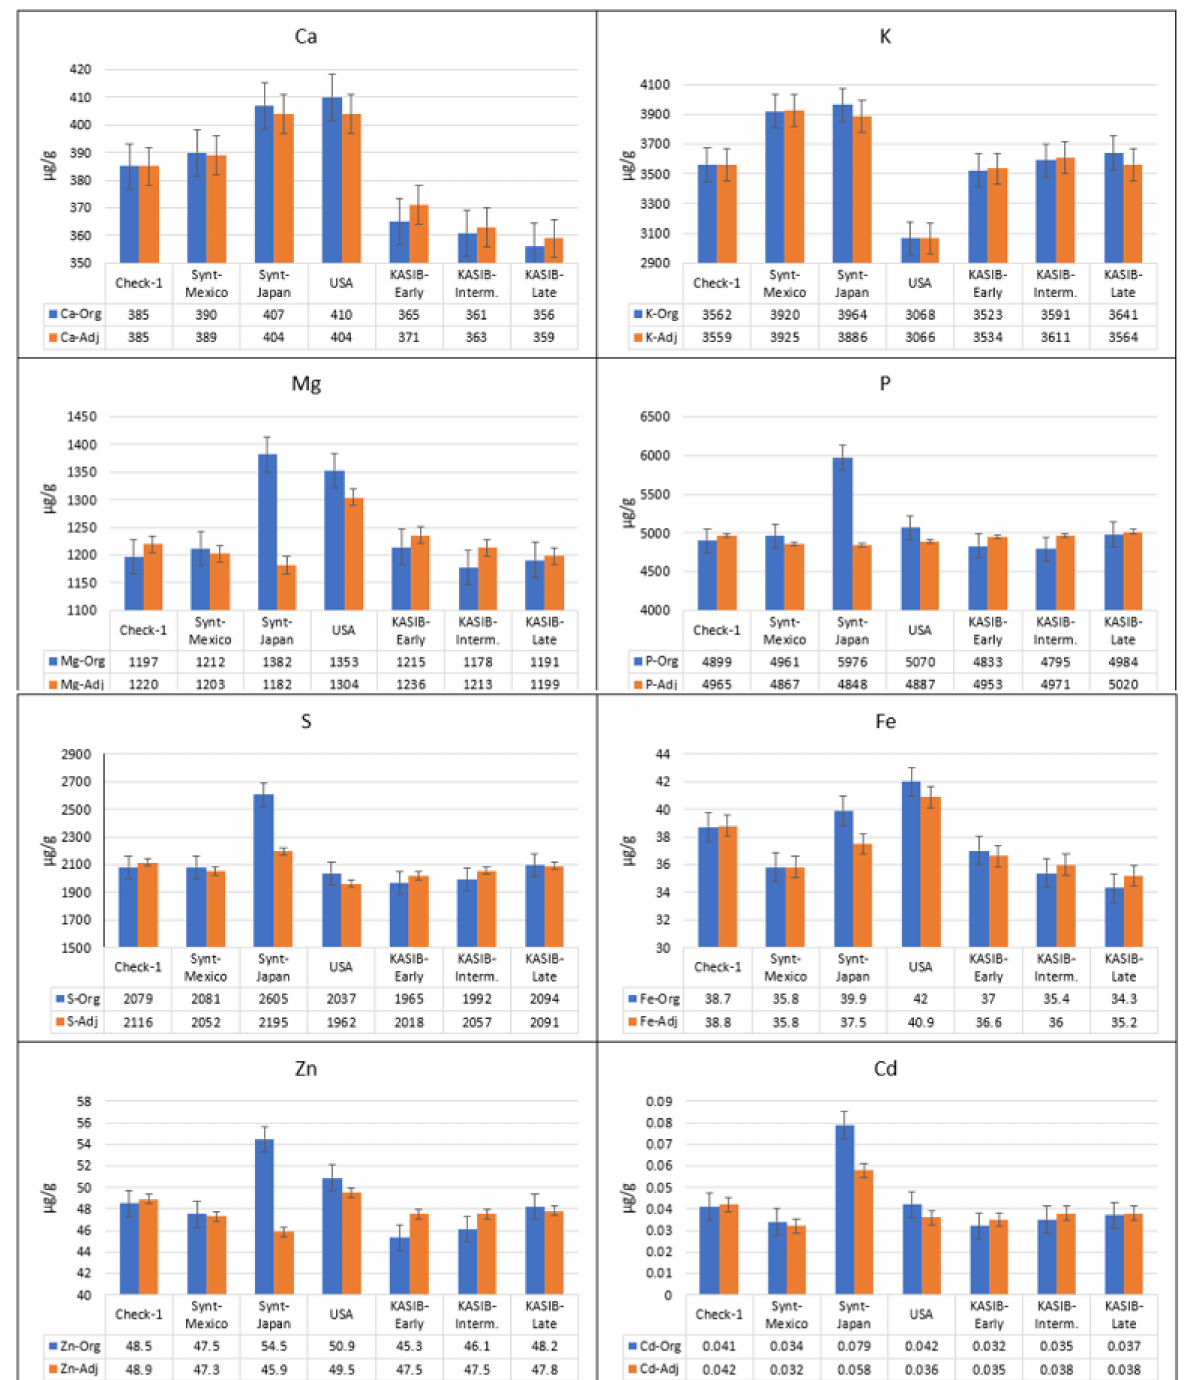
Figure 2. Average grain element concentrations for the genetic resource groups across 2017 and 2018 (blue, original values, and orange, adjusted values), bars represent standard